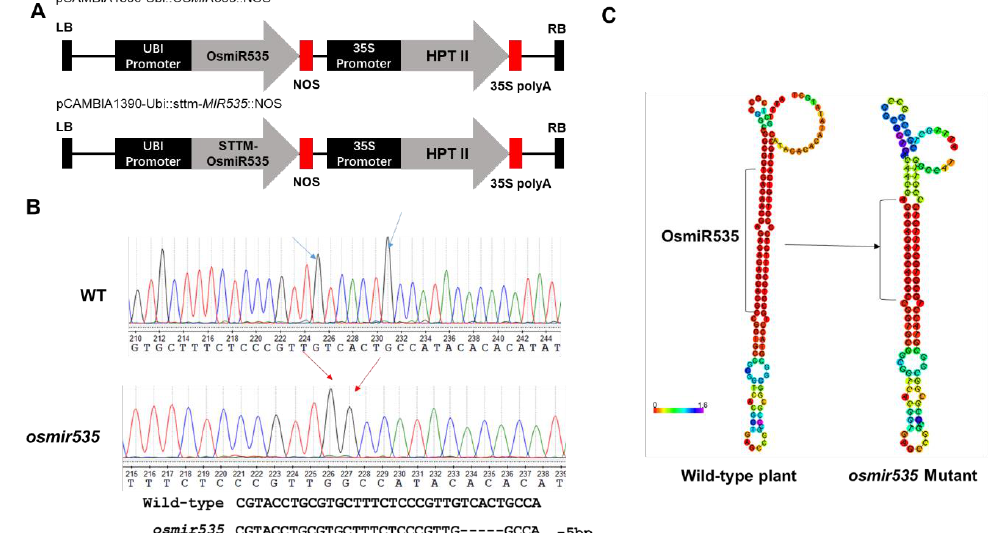
Figure 2. Schematic representation of OsmiR535 -related constructs and the CRISPR/Cas9 genome Figure2. Schematicrepresentation of OsmiR535 -relatedconstructsandtheCRISPR / Cas9genomeediting e ff ect. ( A ) Schematic representation of overexpression constructs pCAMBIA1390-Ubi::OsMIR535::NOS , and the STTM535 construct pCAMBIA1390-Ubi:: sttm-MIR535:: NOS. ( B ) Sequencing diagram of the wild-type (WT) and osmir535 mutant on the OsmiR535 genomic region. ( C ) Predicted OsmiR535 secondary structure of WT and osmir535